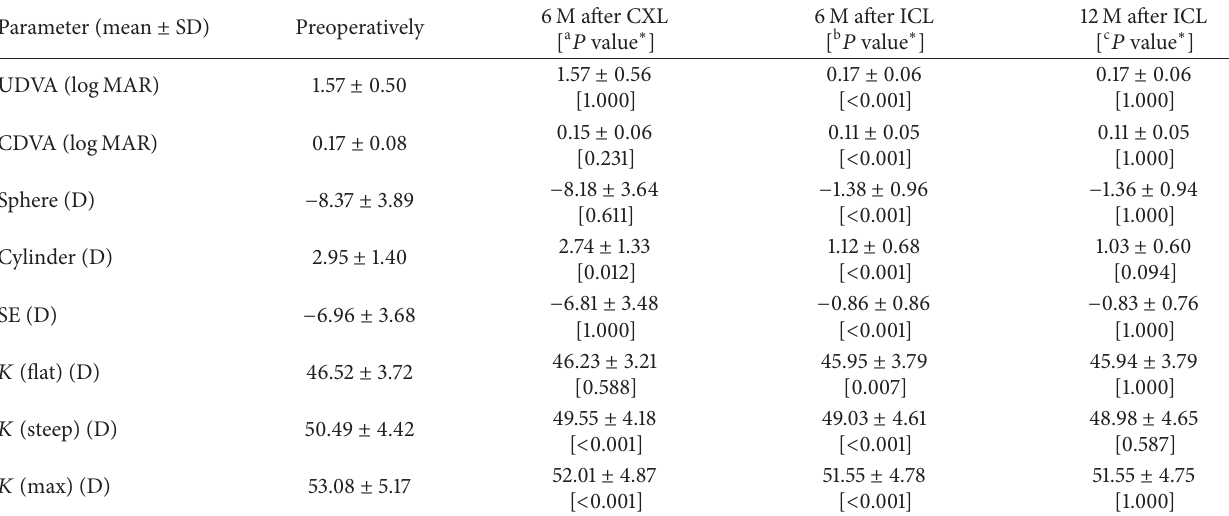
Table 1: Refractive data at baseline, 6 months after CXL, and 1 and 6 months after Visian toric ICL implantation for keratoconus ( 𝑁 = 30 eyes).